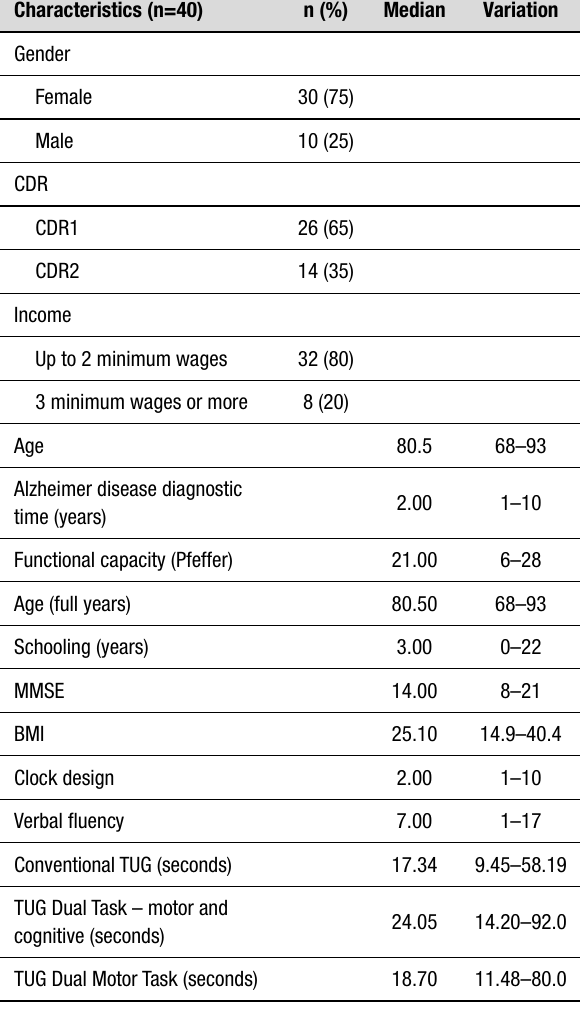
Table 1. Sociodemographic, anthropometric, clinical, cognitive, and mobility characterization of aged people with Alzheimer disease